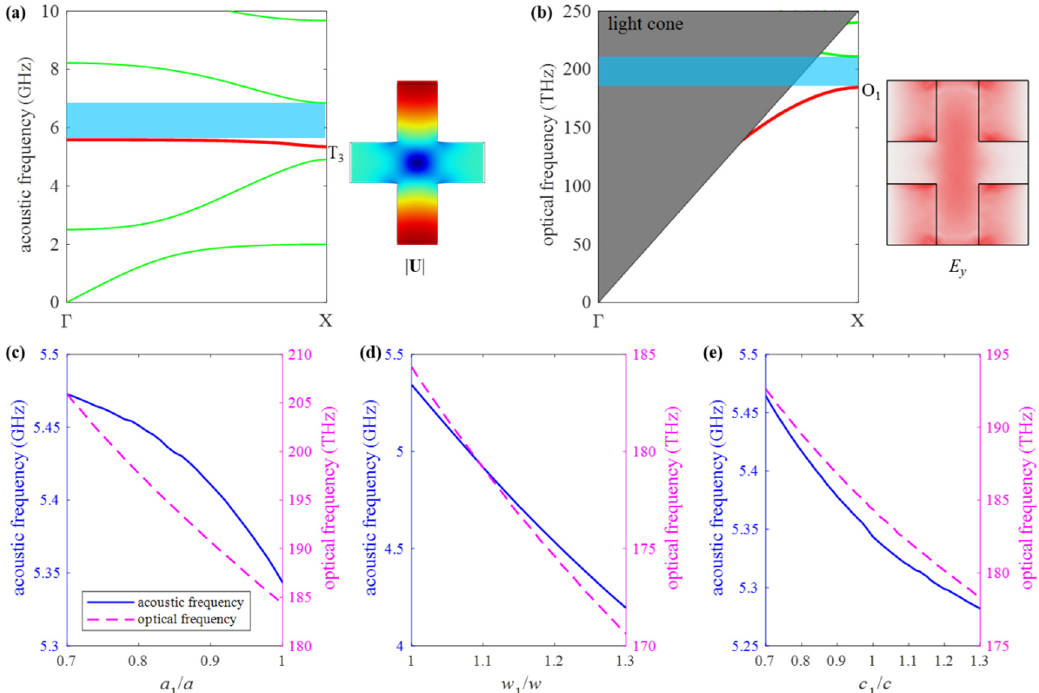
Figure 3. ( a ) With a nominal unit cell, dispersion curve of ( a ) the PnC, and ee symmetric displacement field of the mode T 3 ; ( b ) the PtC with ee symmetric electric field of the mode O 1 . The frequencies of the modes T 3 and O 1 vary with the geometrical parameters; ( c ) a 1 , ( d ) w 1 , ( e ) c 1 .